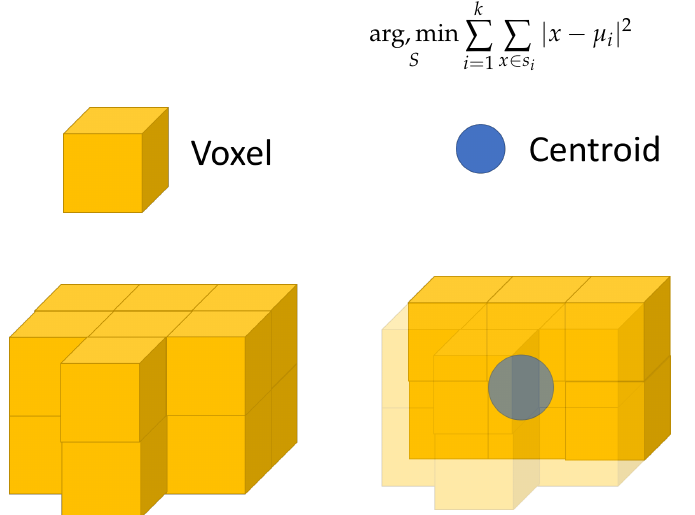
Figure 10. Figure showing centre point of a detected object.